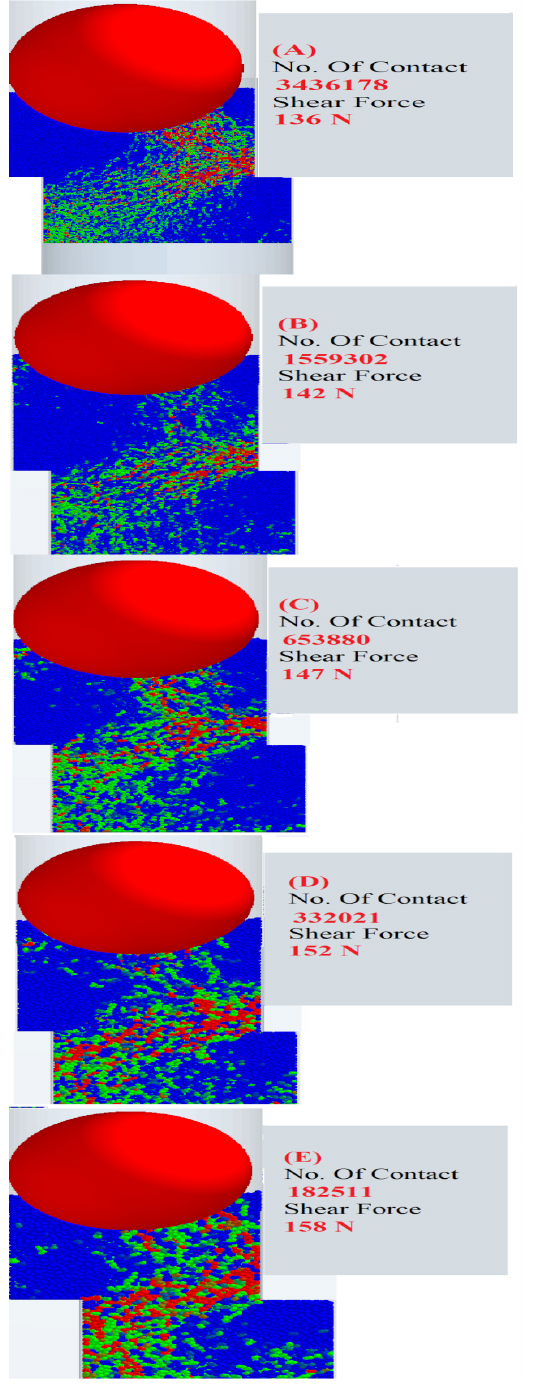
Figure 12 Distribution of contact force chains for various SIparticles at shear strain of 15% and 30kPa normal stress (Size index SI= 50%, 75%, 100%, 125%, 150%